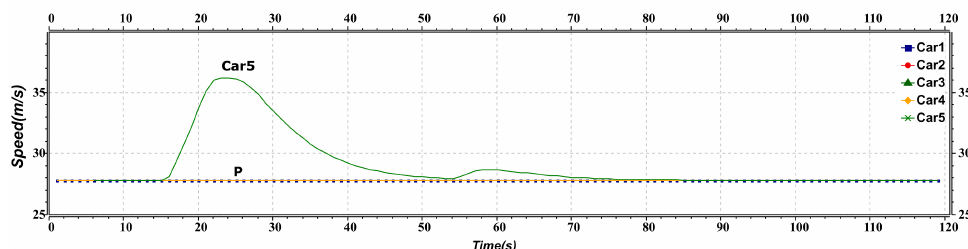
Figure 8. Speed versus time graph of joining maneuver. Figure 9 represents the distance versus time of the joining maneuver of the platoon and